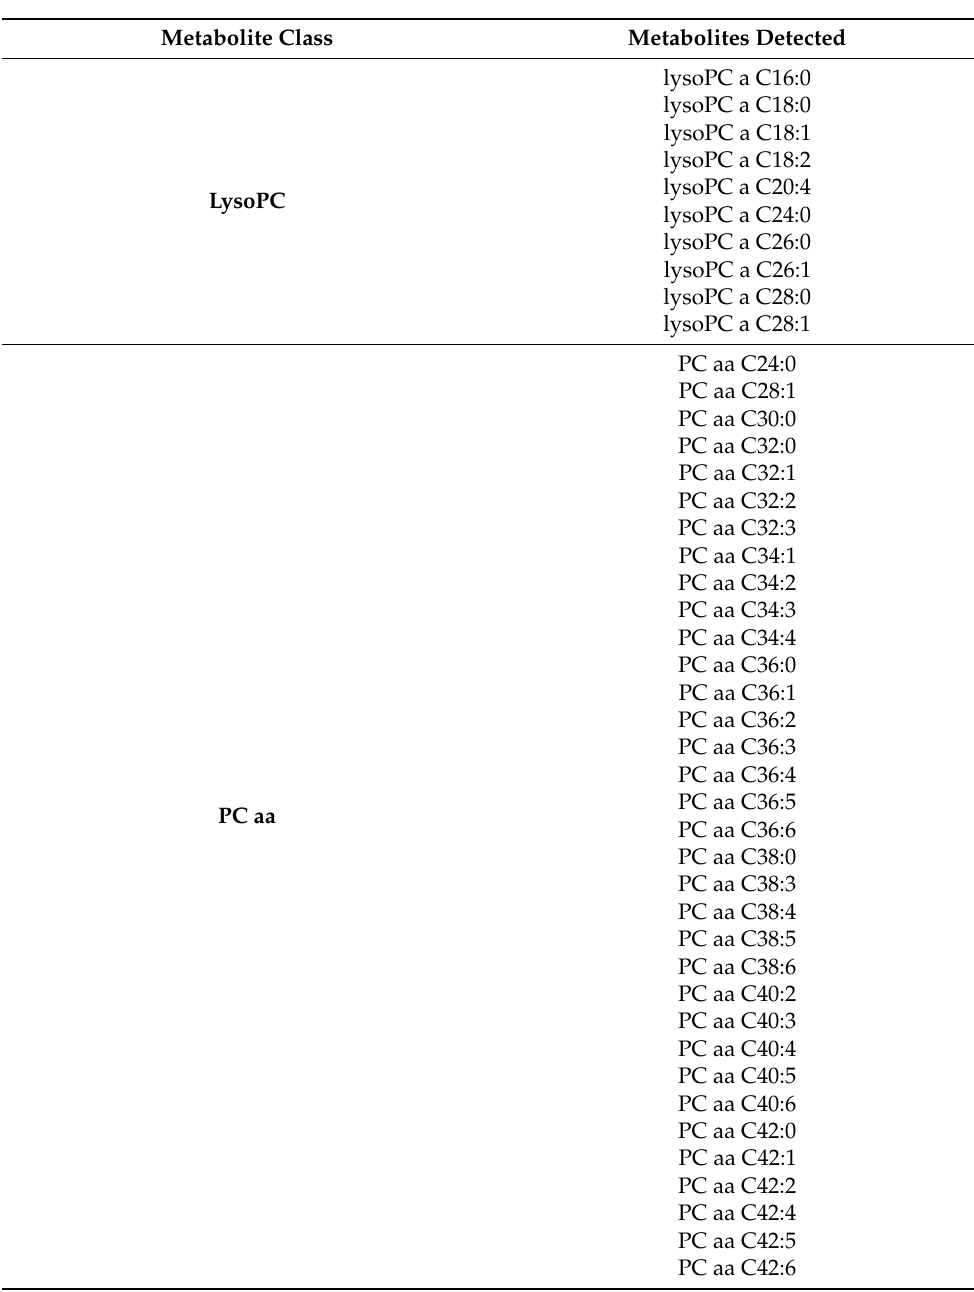
Table A1. Lipid classes and single lipids detected in EV samples using the Biocrates IDQ ® p180 kit (Biocrates Lifesciences, Innsbruck,